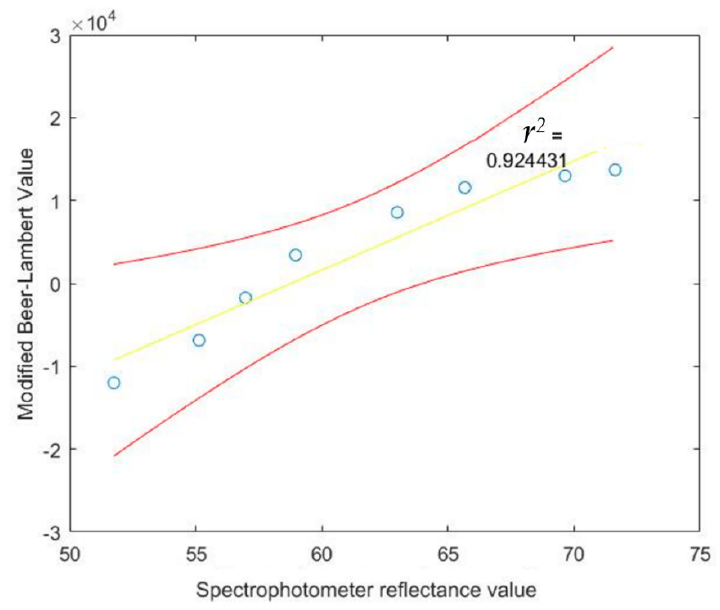
Figure 10. The 95% confidence interval of the regression line relating spectrophotometer reflectance value at difference Hb concentrations and calibrated value.